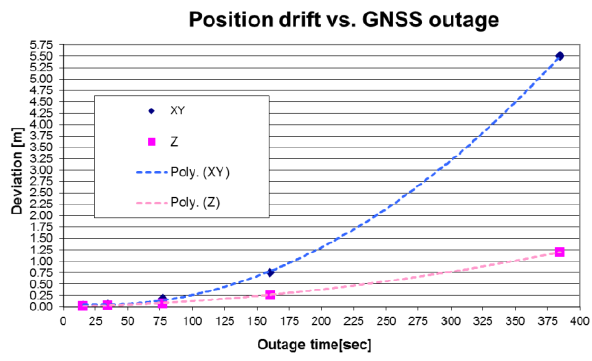
Figure 7: Computed trend curve for position drift in function of GNSS outage time for a navigation grade